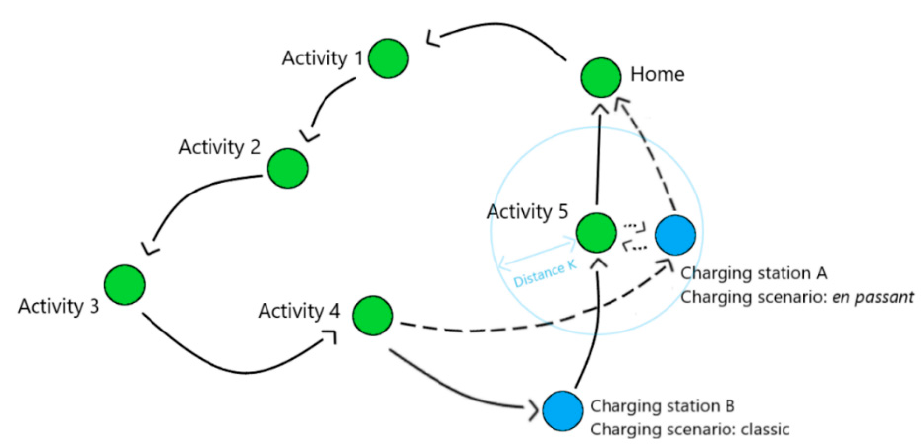
Figure 4. The difference between the classic and the en passant charging scenarios, and the role of distance